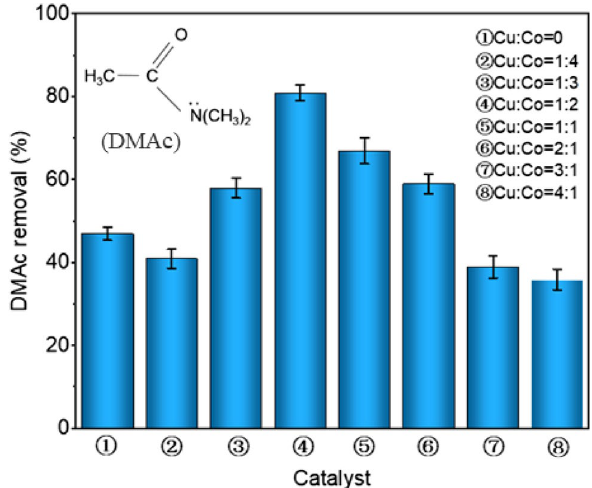
Fig. 6 Removal of N , N -dimethylacetamide (DMAc, 18,000 mg/L) in industrial wastewater with bulk-solution Fenton-like process with various catalysts (conditions: 2.4 g/L catalyst and 2.4 M H 2 O 2 at pH = 7.6 and 25